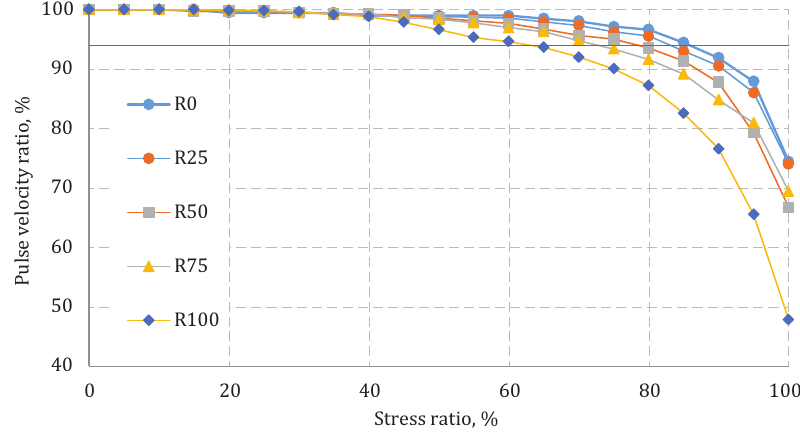
Figure 15. UPV lines against applied compressive stress in the RCC mixtures containing different amounts of